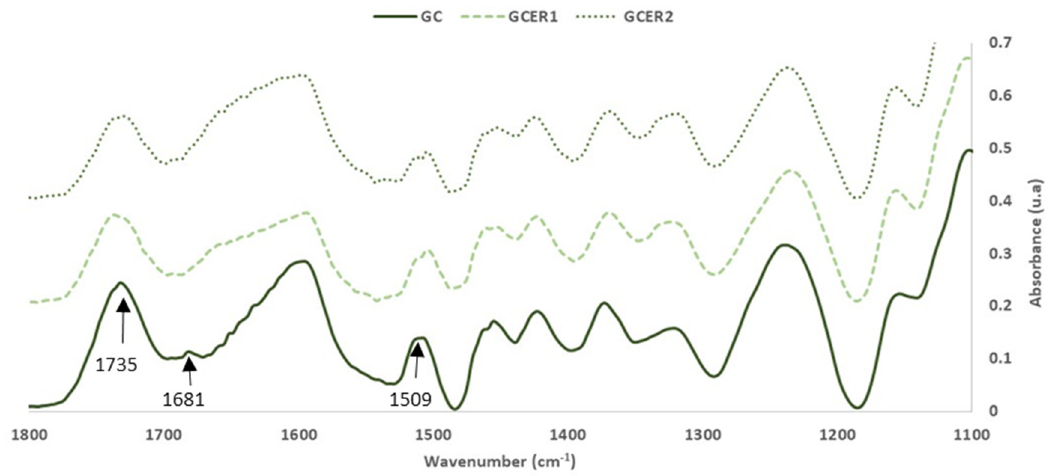
Figure 2. FTIR spectra: Solid grape canes before (GC) and after (GC ER1 , GC ER2 ) the extraction process (1100–1800 cm − 1 ).